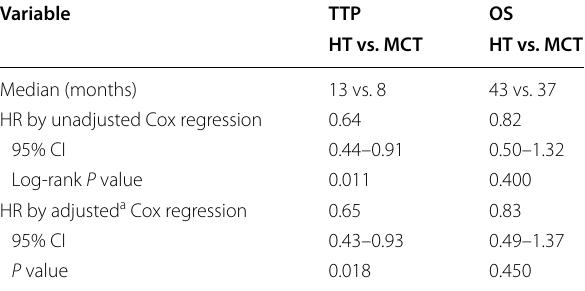
Table 3 Efficacy analysis of time to progression and over- all survival by unadjusted and adjusted Cox proportional hazards models